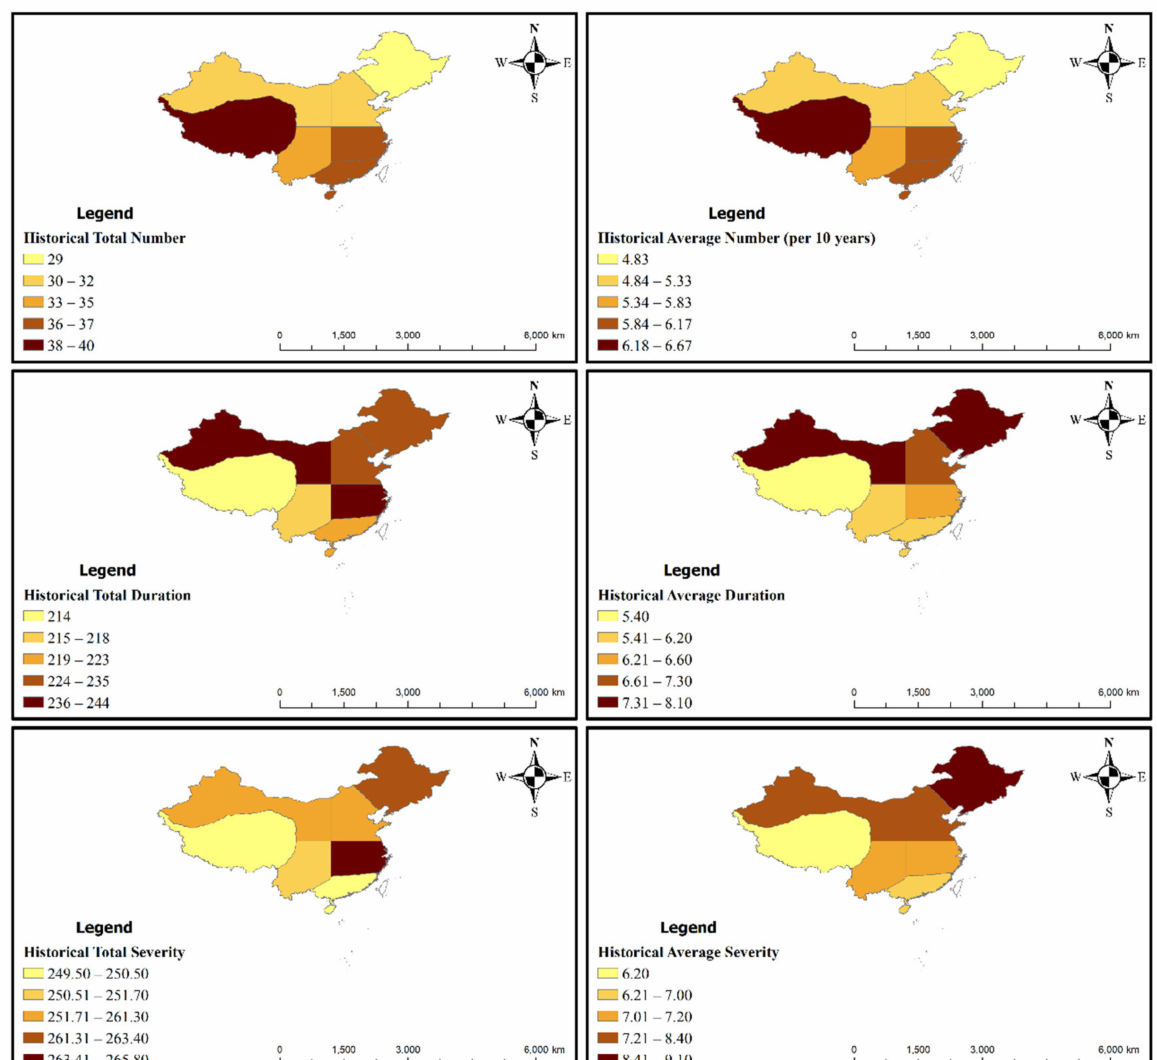
Figure 4. Spatial map of meteorological drought characteristics in the historical